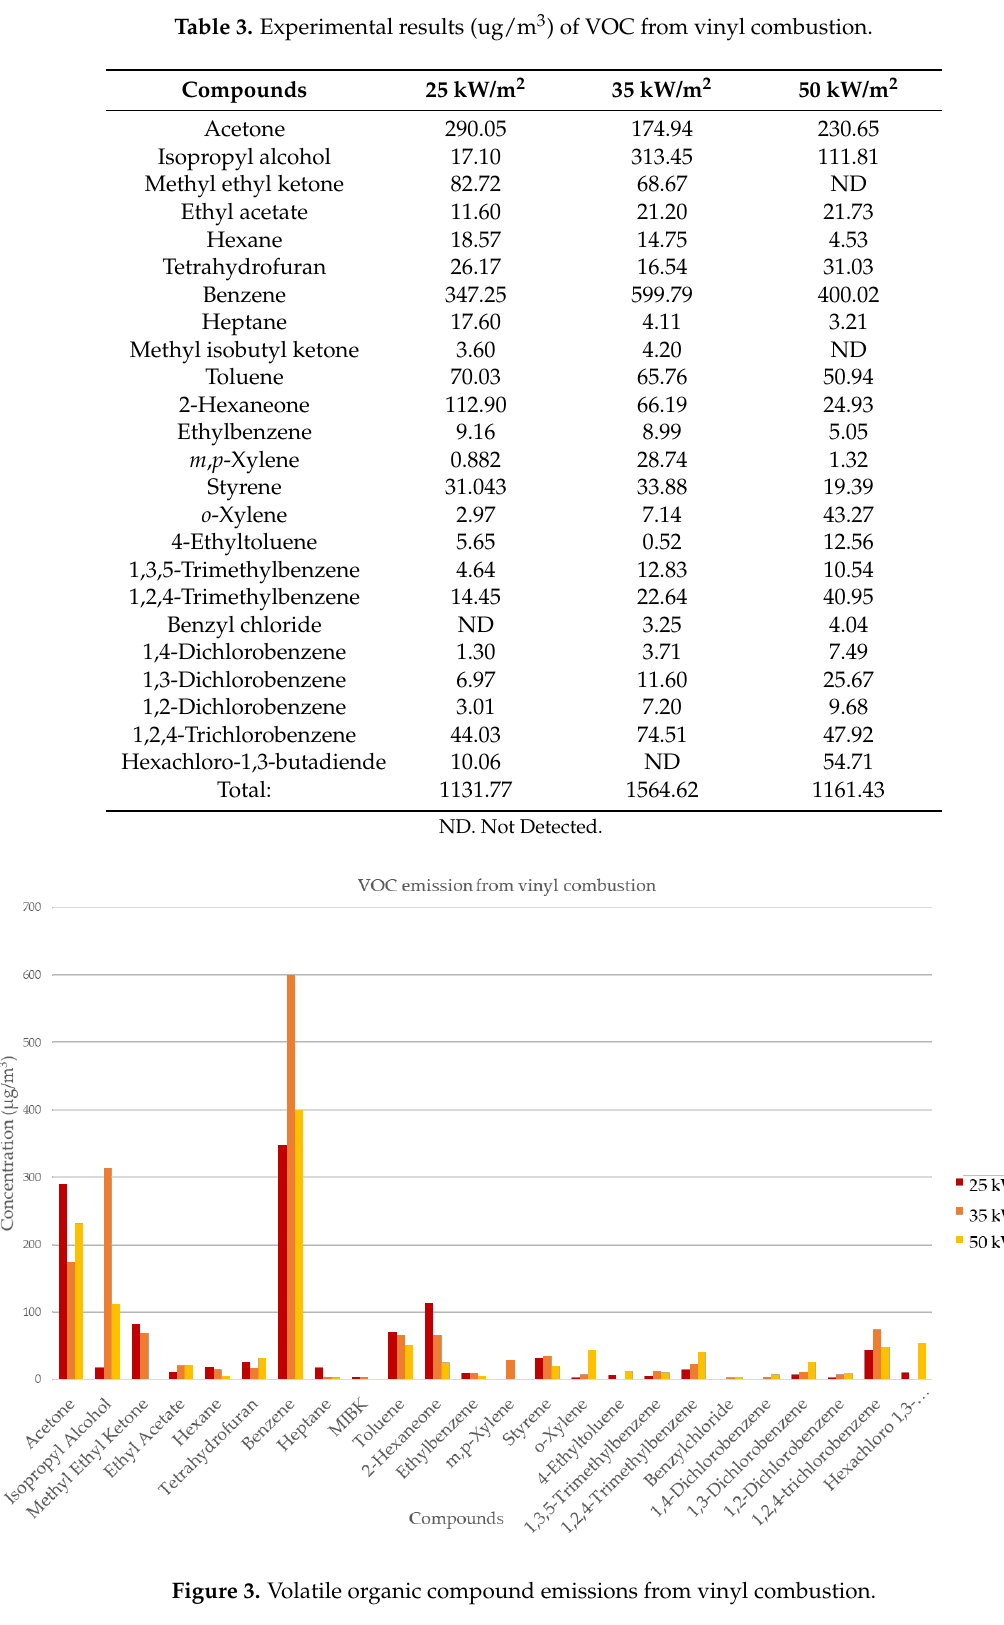
Figure 3. Volatile organic compound emissions from vinyl combustion. Table 4. Emission factors (mg/kg) of VOCs from the combustion of vinyl.